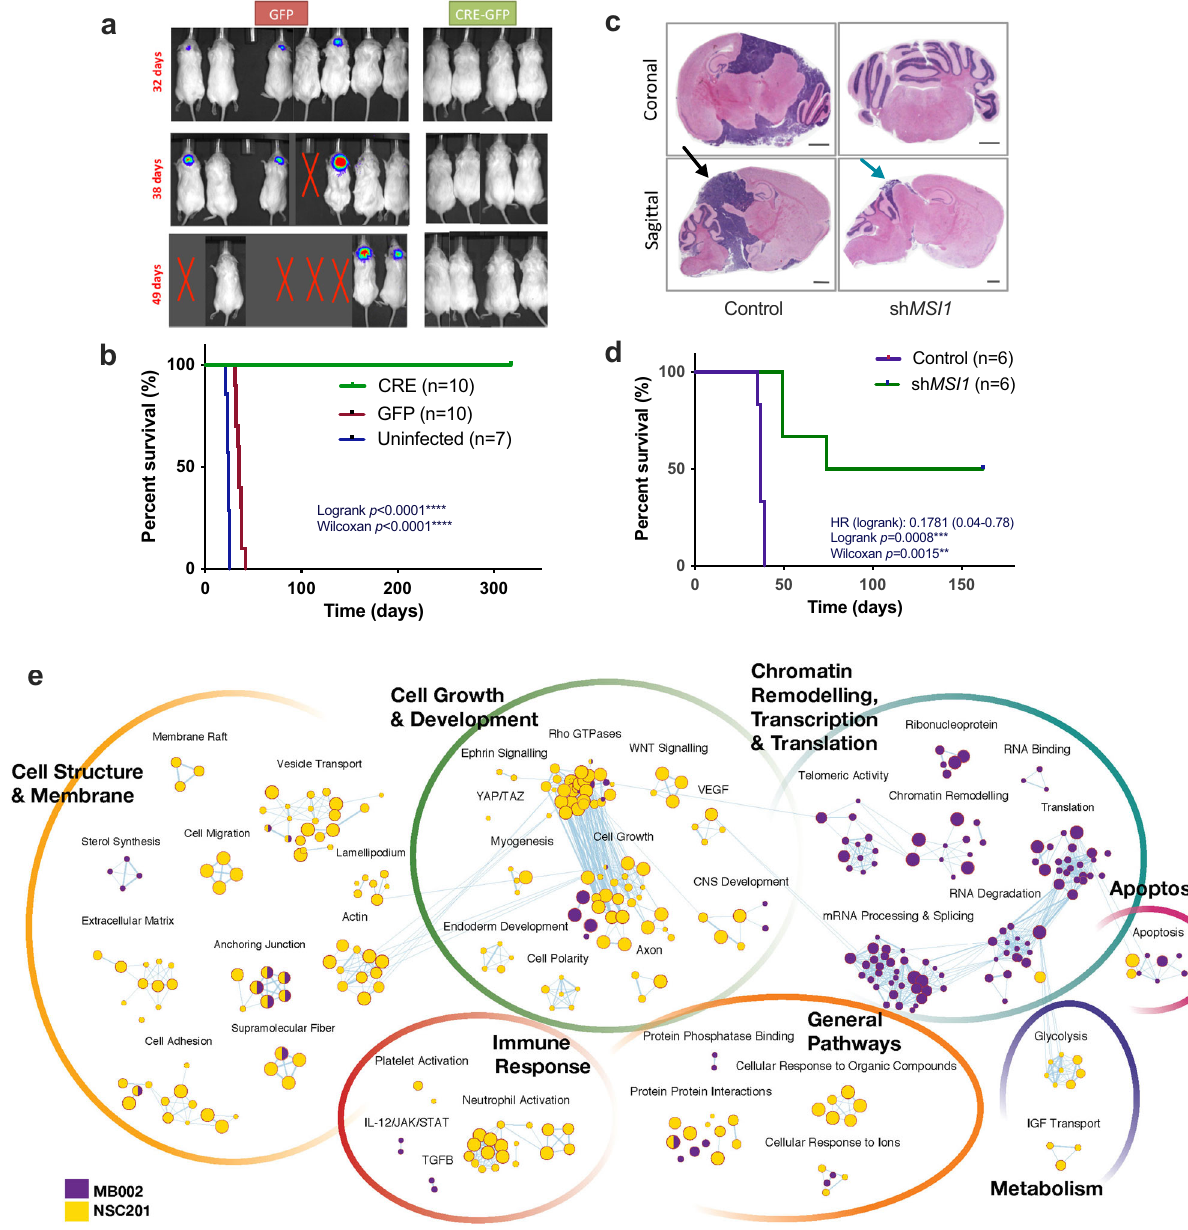
Fig. 1 | MSI1 is overexpressed in G3 MB. a Tumor burden analysis of mice ortho- topicallytransplanted withCre-infectedMsi1 fl ox/ fl ox showingnoluminescenceinCre mediated Msi1 KO MP tumors indicating impaired tumor formation compared to GFP control mice, b Kaplan-Meier survival analysis of Cre-mediated Msi1 KO mice ( n =10), control GFP mice ( n =10) and untransduced MP mice ( n =7) illustrating a clear survival bene fi t for the Cre-mediated Msi1 KO cohort ( p <0.001), c 24 NOD- SCID mice were engrafted with SU_MB002 with 2.5×10 4 cells. H&E stain of control